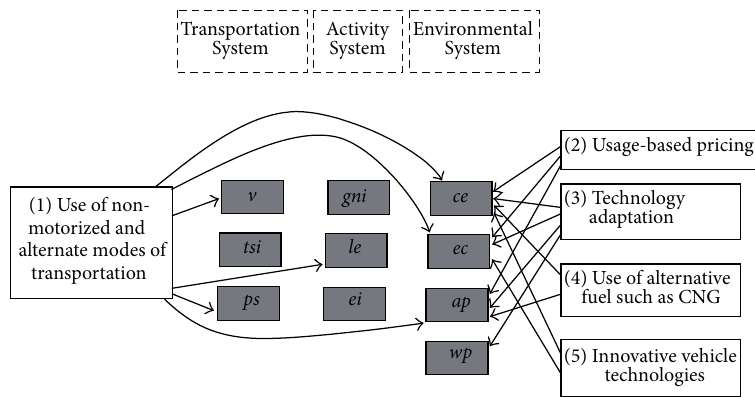
Figure 6: Direct effects of policy options on Performance